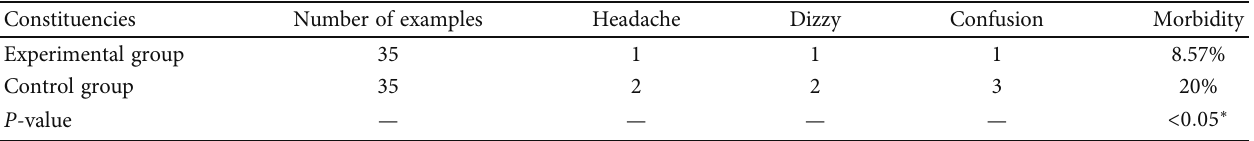
Table 2: Comparison of incidence of complications between the two groups ( (cid:1) x ± s ).